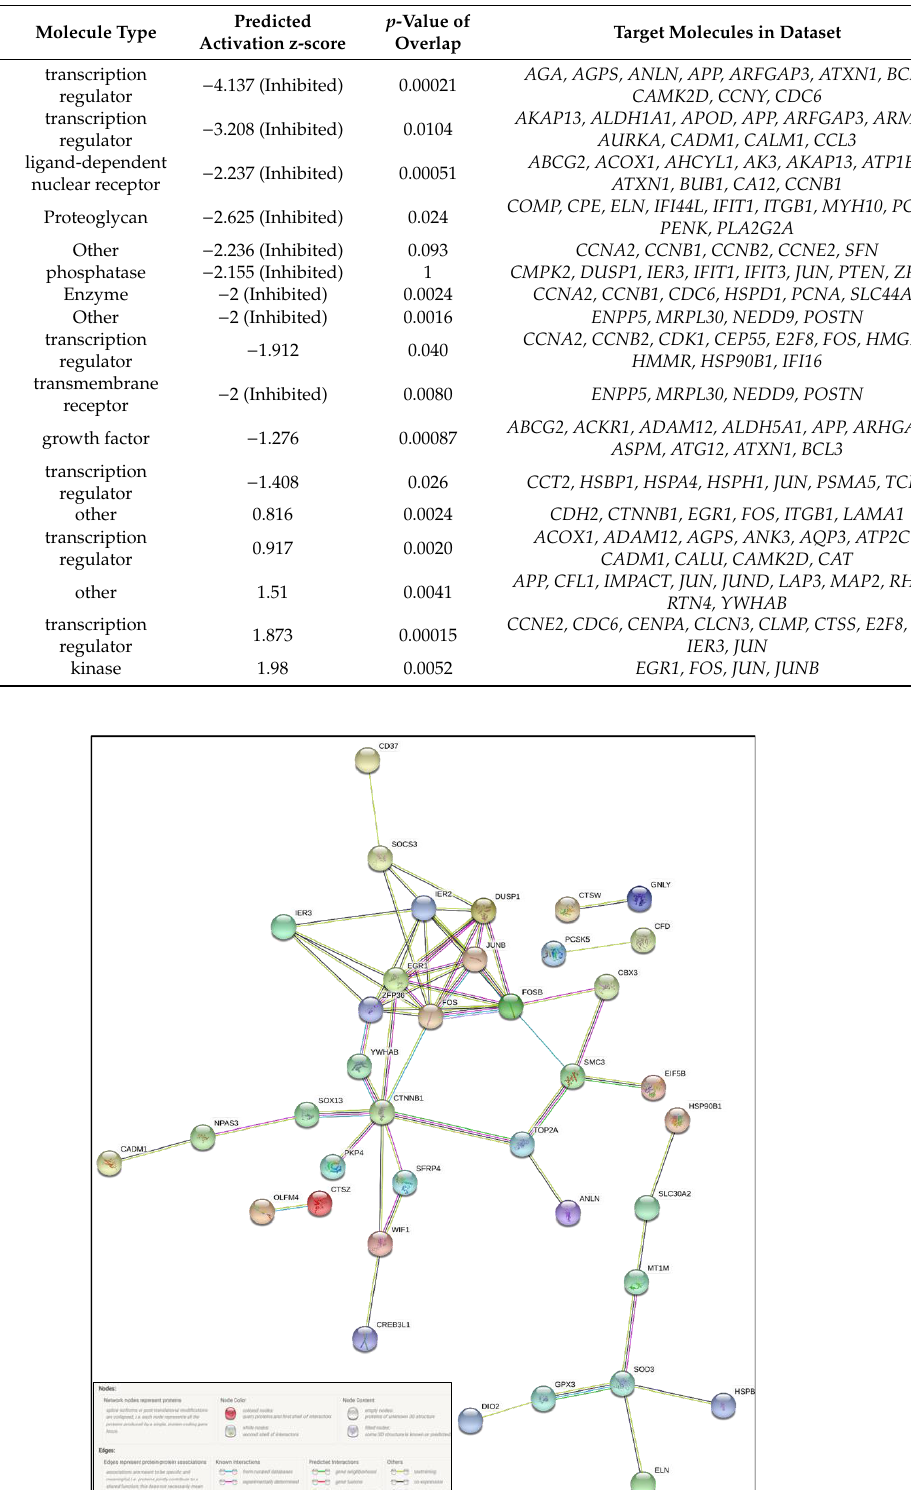
Table 5. Most significant upstream regulators and target molecules in endometriosis dataset.